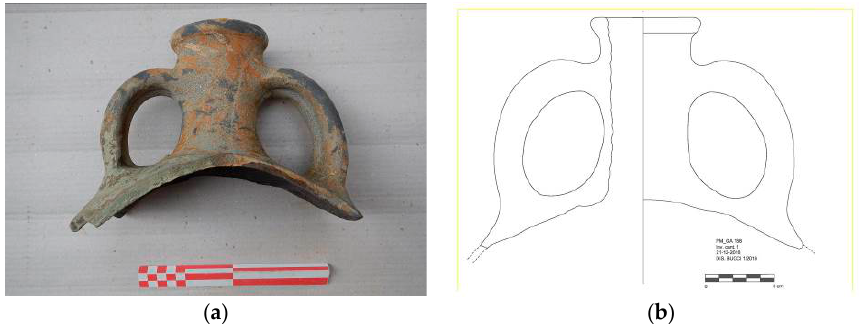
Figure 21. Fragments of Late Roman Amphora found in Lago Tramonto, Gambulaga, Portomaggiore (FE, Italy): ( a ) Photo with metric reference; ( b ) 1:1 draw (by Giovanna Bucci).